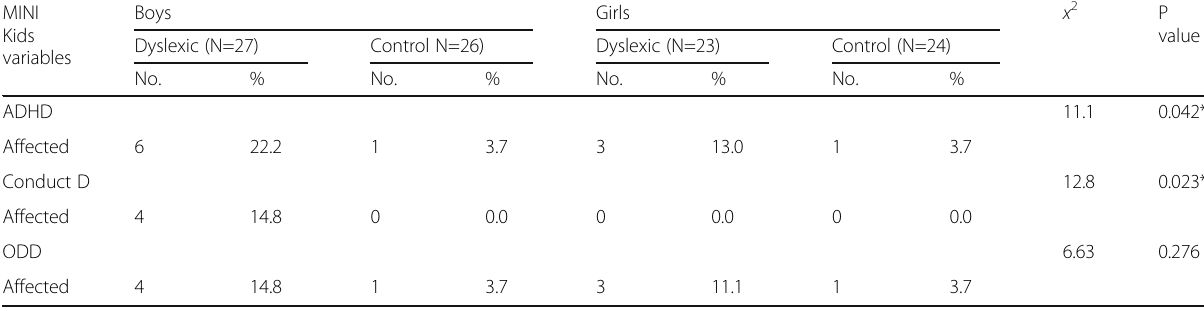
Table 3 Frequency distribution of ADHD, CD, and ODD in boys and girls of studied groups according to MINI kids